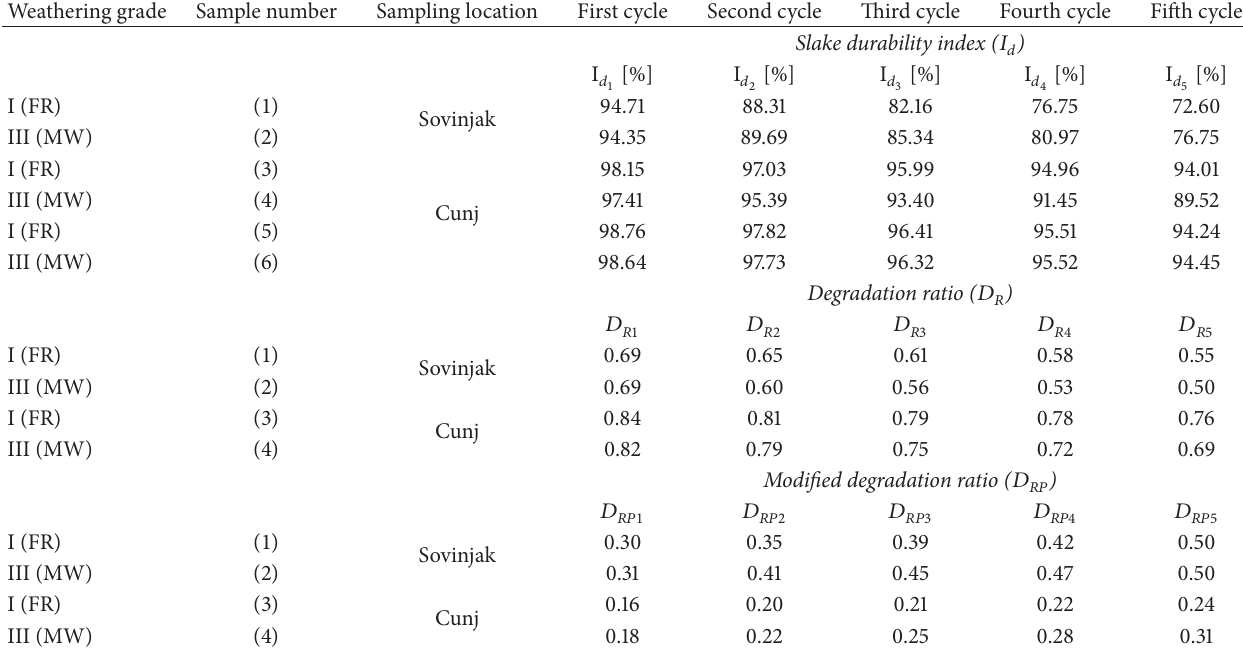
Figure 7: Example of a heavily degraded siltstone sample of weathering grade I (FR) (1) taken from a flysch outcrop near Sovinjak Village = 88% and I = 73%. after five cycles of the slake durability test with I d 2 d 5 Table 4: Results of five cycles of the slake durability tests, including the slake durability index, degradation ratio, and modified degradation ratio, for siltstones of different weathering grades in the study